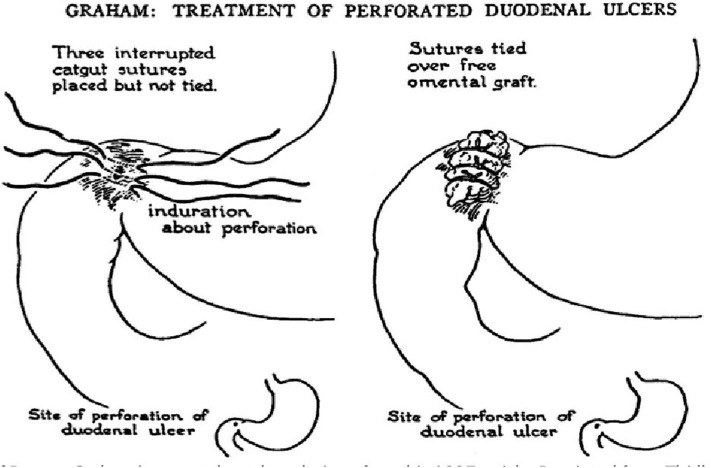
Schematic diagram of omental (Graham) patch technique (plugging with non-pedicle omental flap) [with permission: Graham (29)].